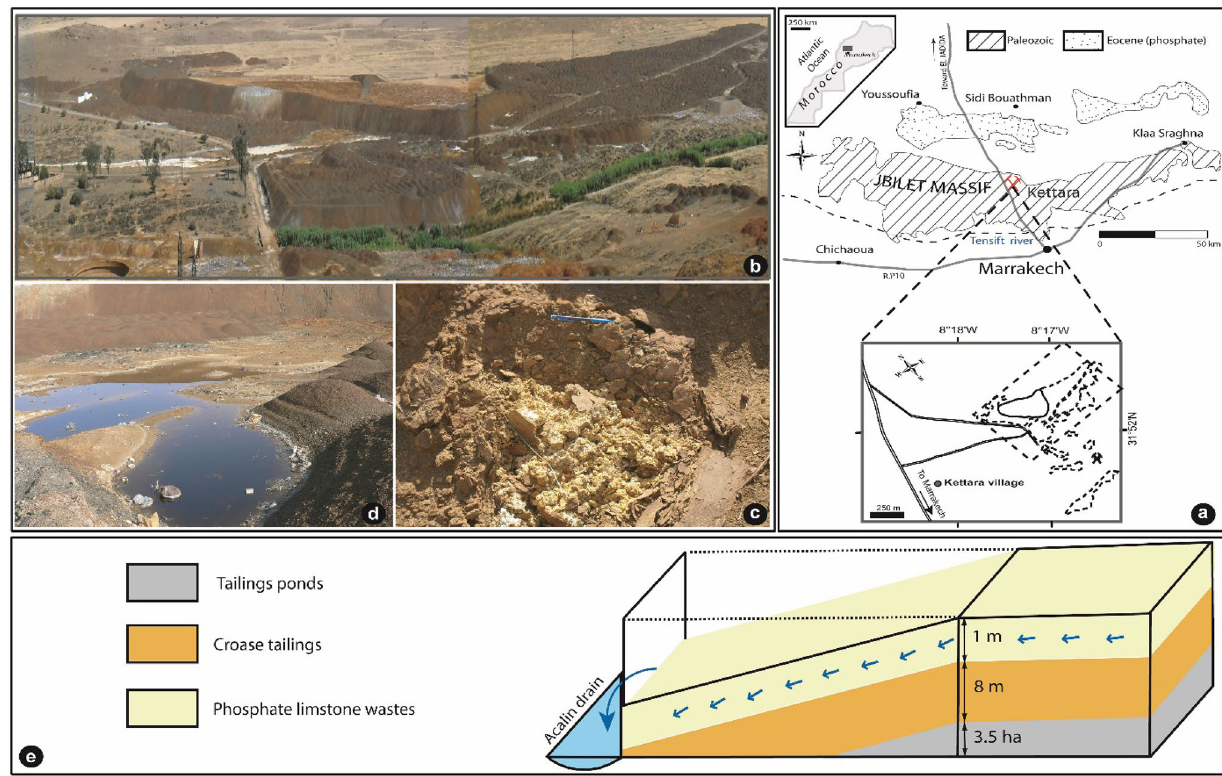
Fig. 1 Location of the study area ( a ), panoramic view of Kettara mine wastes ( b ), secondary minerals ( c ) and AMD effluent ( d ), ( e ) the alka- line phosphate waste (APW)